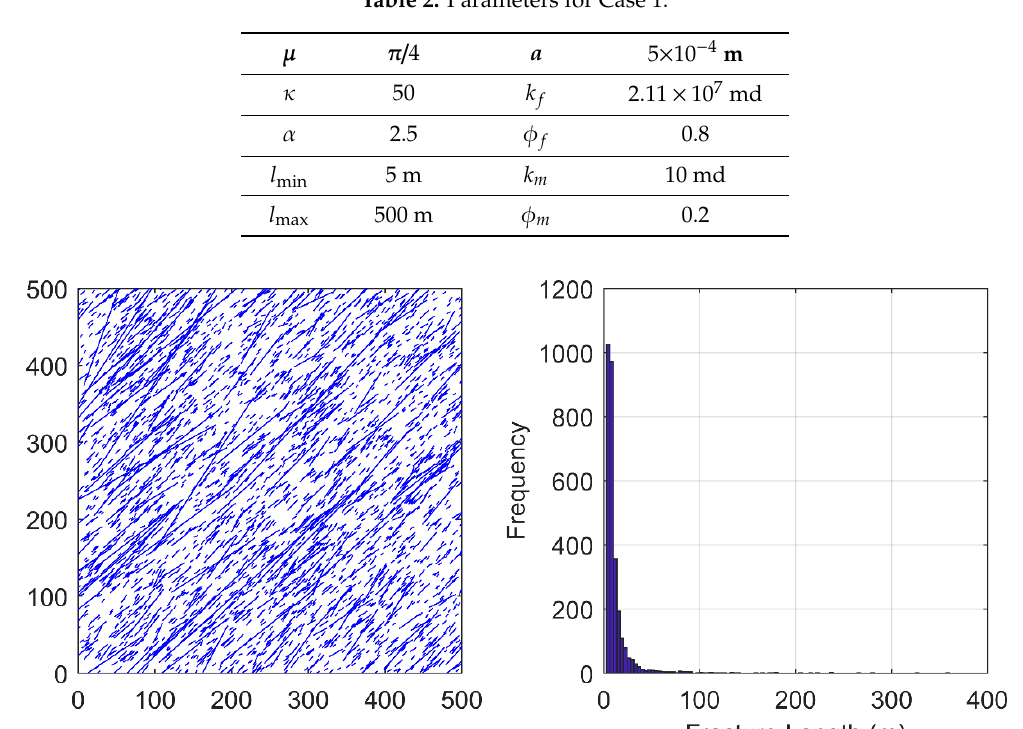
Figure 5. ( Left ) DFN on a square domain with dimension 500 m × 500 m. ( Right ) Histogram of fracture length distribution.